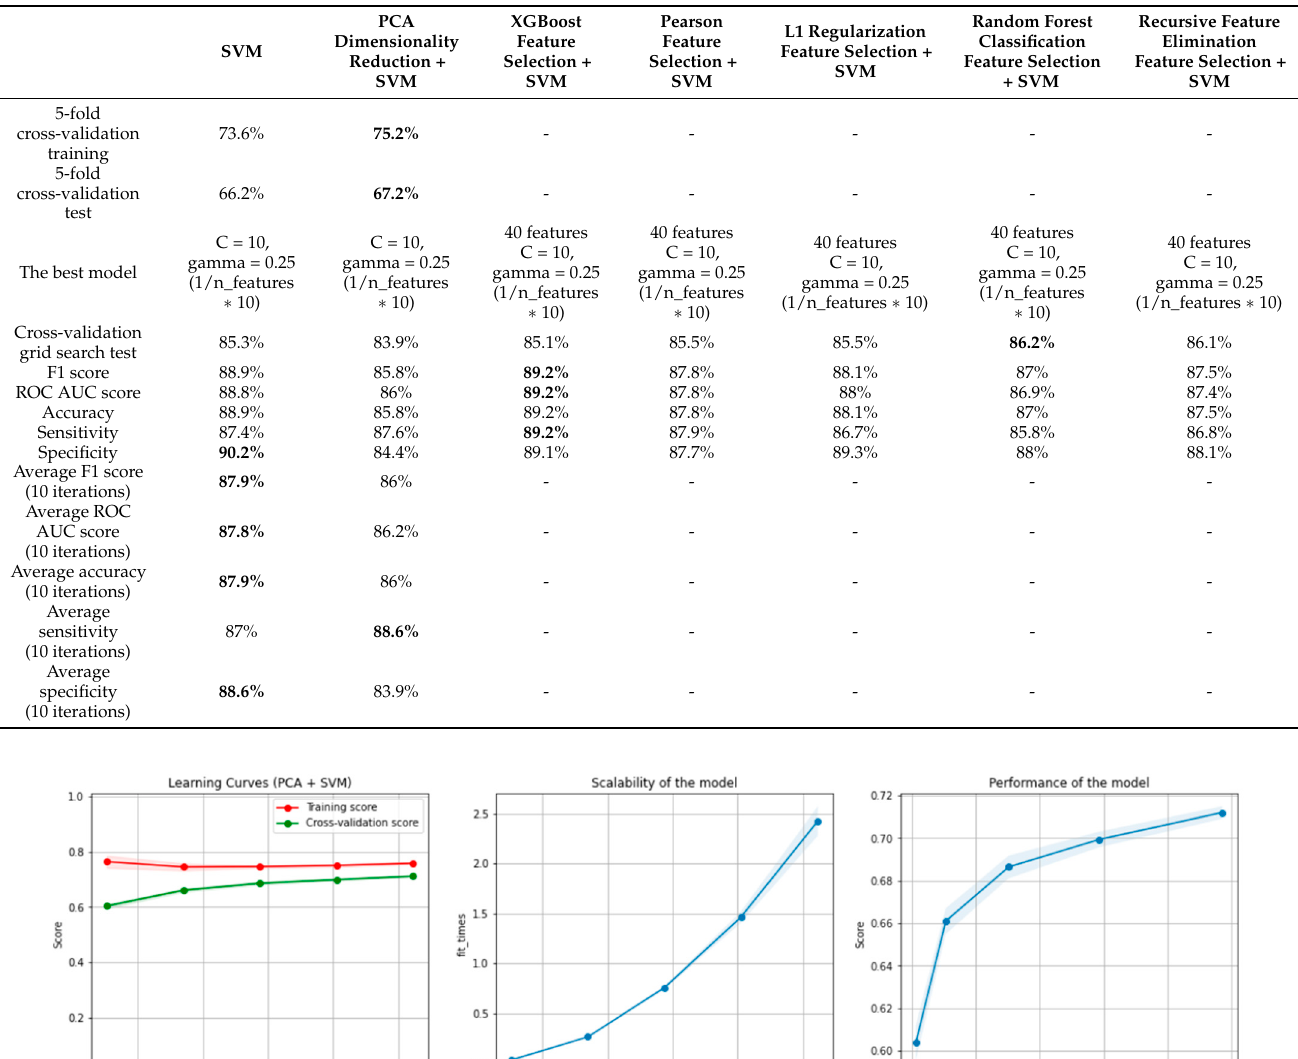
Table 5. Results of the SVM algorithm applied on the overlapping dataset.